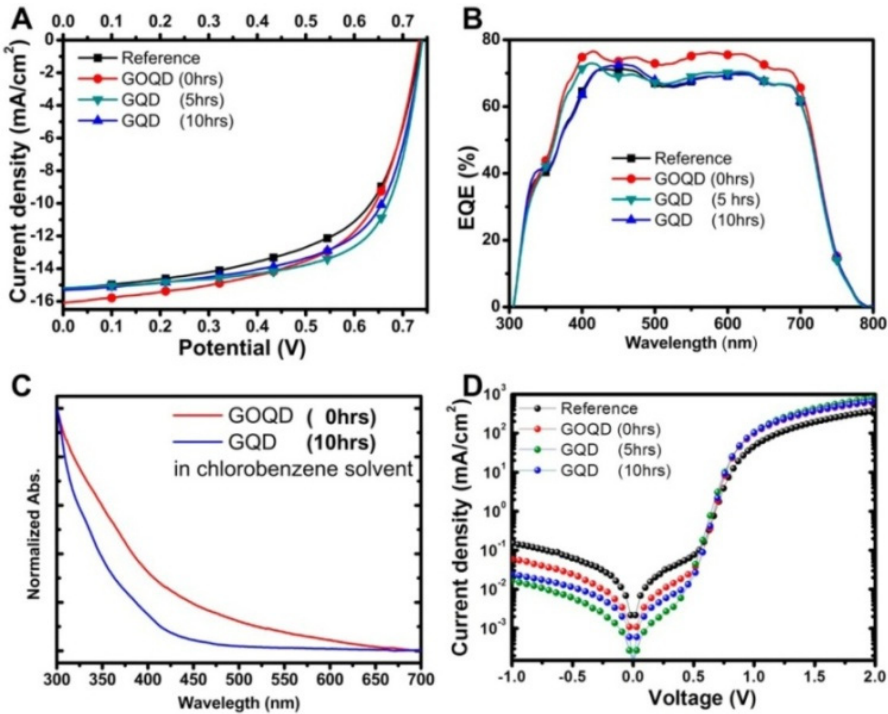
Figure 7. ( A ) Current versus potential J-V curves of the reference and three different GQD-BHJ devices. ( B ) Incident photon to charge carrier efficiency (IPCE) of the reference and GQD-BHJ devices. ( C ) UV-visible adsorption spectra of GOQD and GQD 10 in chlorobenzene. ( D ) Dark J-V curves of the BHJ devices with no GQDs (black), GOQD (red), GQD 5 (green), and GQD 10 (blue). Reprinted with the permission of Reference [89]. Copyright 2013 American Chemical Society.